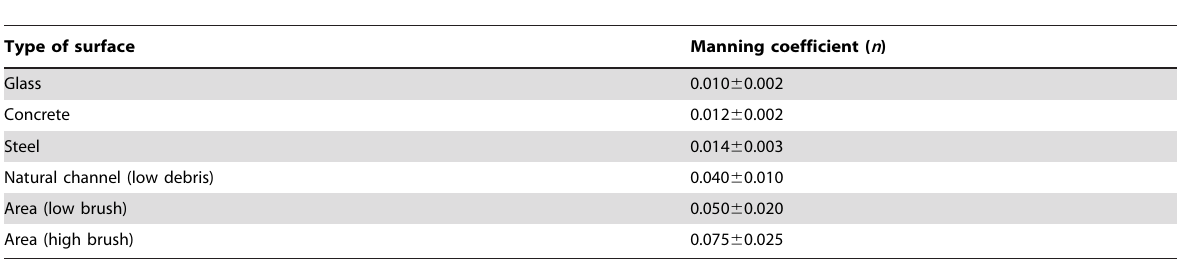
Table 2. Values of Manning coefficient according to the material of the surface.